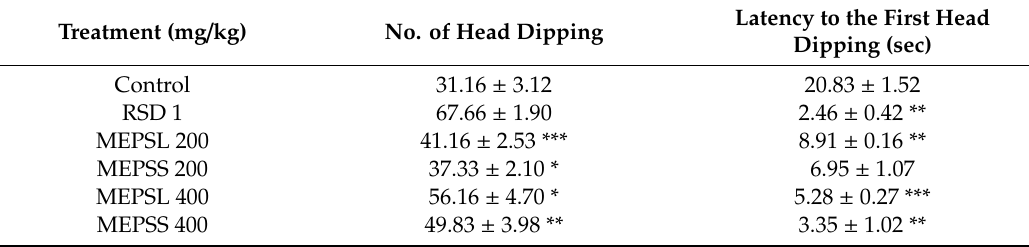
Table 2. Anxiolytic e ff ects of MEPSL, MEPSS, and diazepam in hole board test in mice. Treatment (mg /